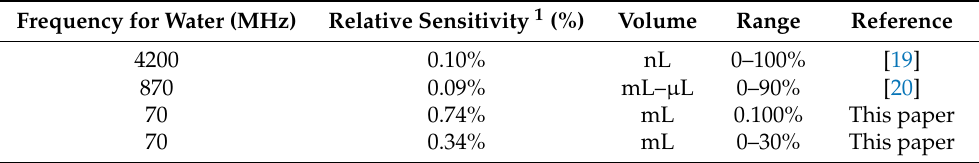
Table 2. Comparison with similar methods for the analysis of water-ethanol solutions. Frequency for Water